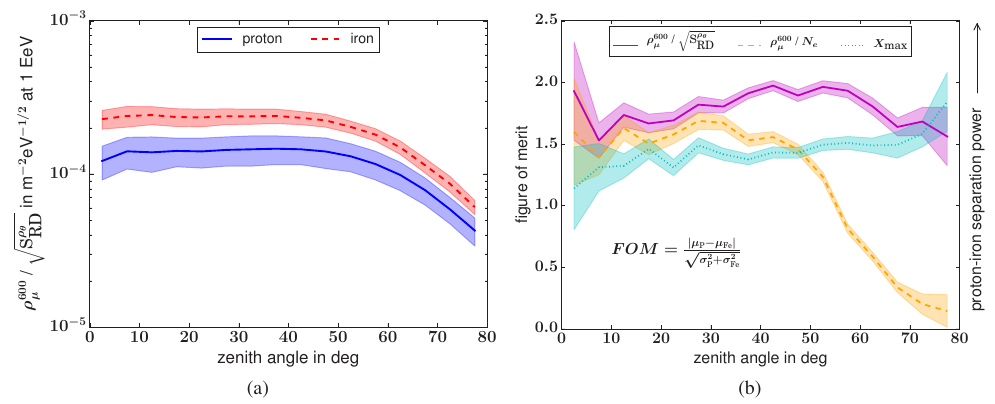
Figure 1 . (a) Muon-radio mass estimator versus zenith angle for showers with a primary energy of 1 EeV. The lines show the mean values µ i and the shaded areas depict the standard deviations σ i . (b) Mass separation power of di ff erent mass estimators, represented by the figure of merit (FOM). The indices signify proton (P) and iron nuclei (Fe). No uncertainties from detector e ff ects are